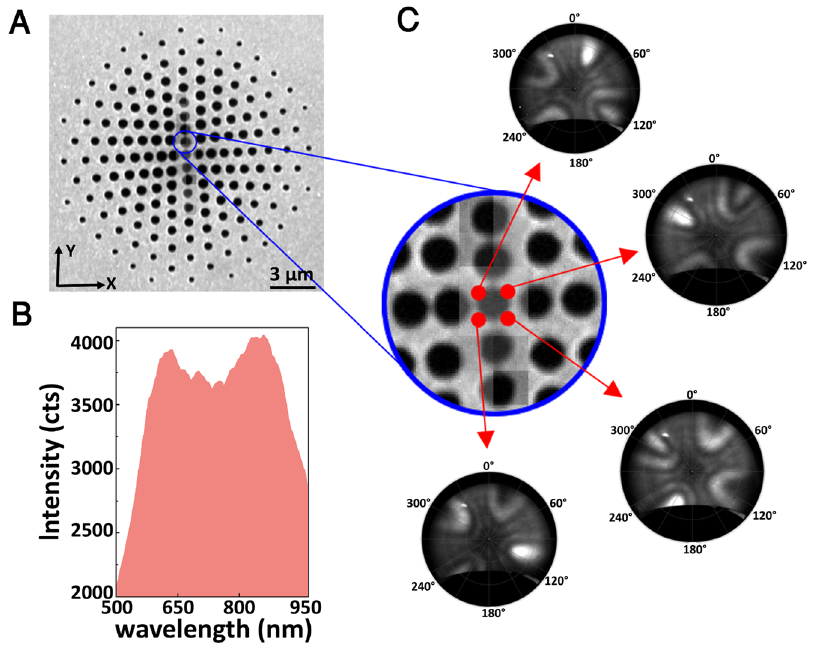
Figure 13: (A) Angle-resolved CL maps from the structure versus the electron impact position. (B) Integrated spectrum for the scanned region involving the central nanopinhole. CL,